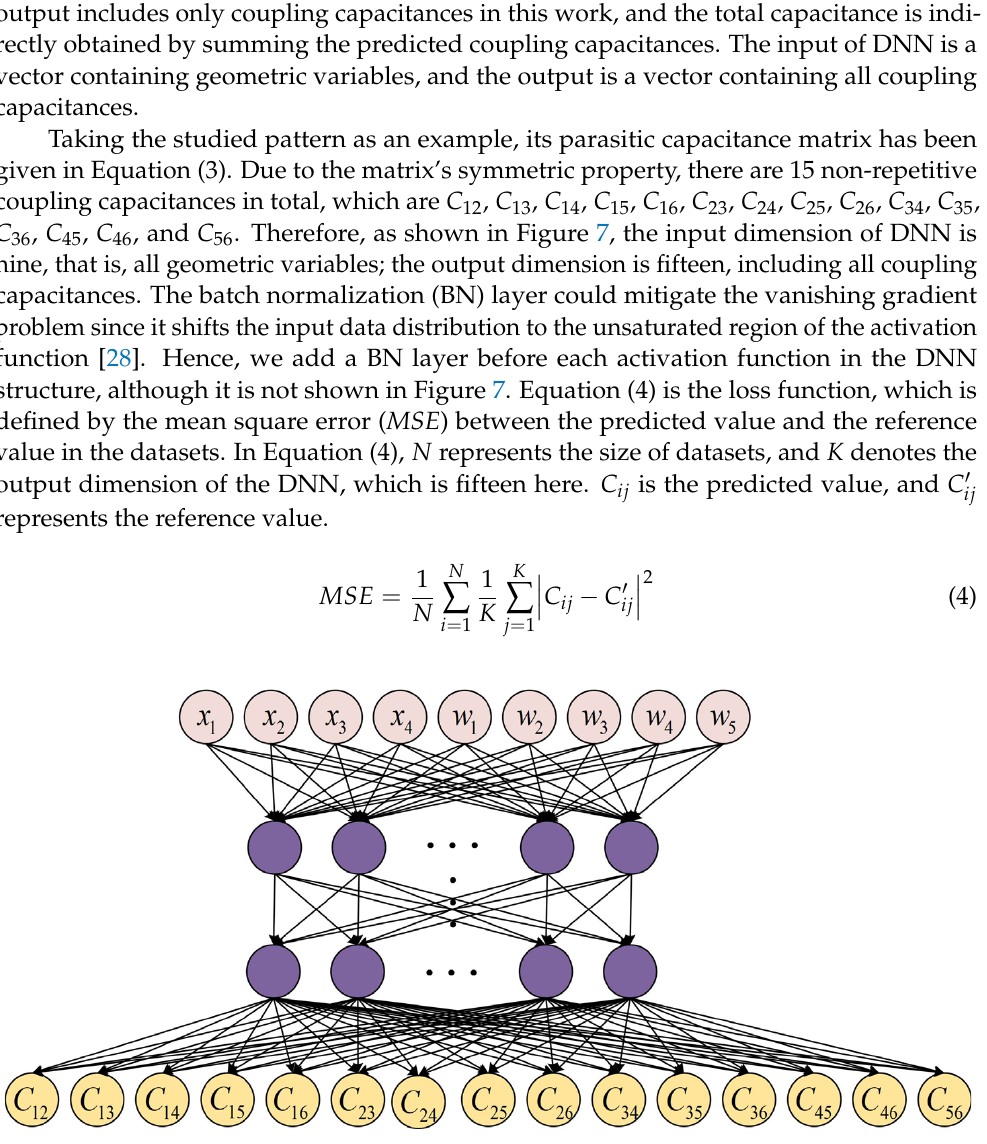
Figure 7. The illustration of DNN structure.